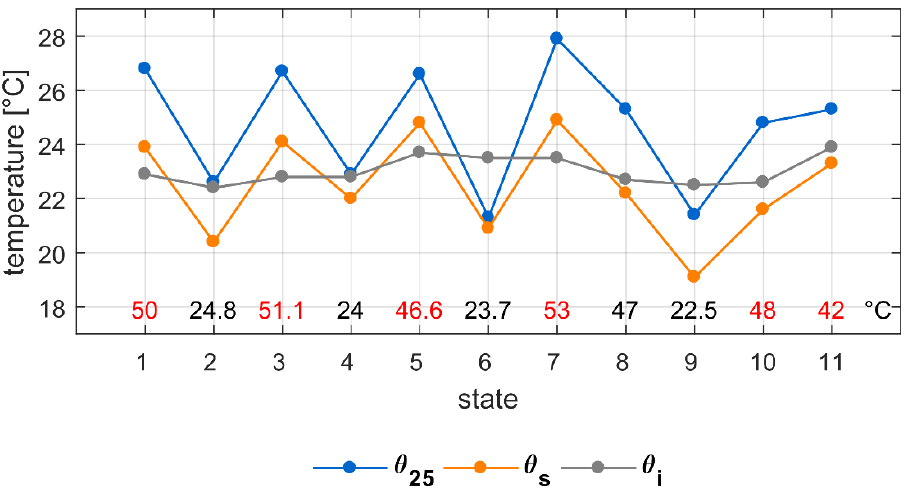
Figure A5. Measured temperatures in the center of the roof window for different states of the heating body. θ 25 is the temperature at a distance of 25 mm from the surface, θ s is the temperature at the surface, and θ i is the air temperature at the center of the room. The temperature of the heating body is shown in the bottom row.